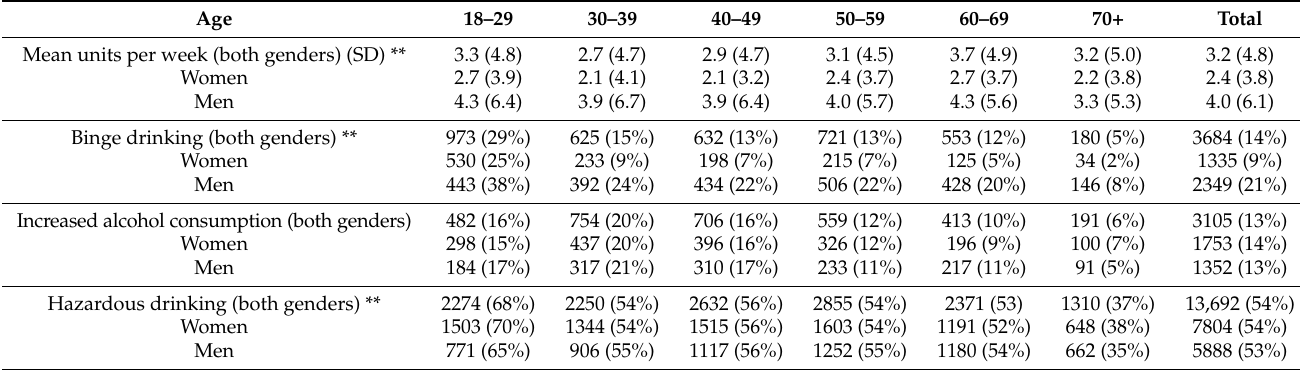
Table 2. Alcohol consumption, binge drinking, and increase in alcohol consumption in relation to age for all respondents, as well as for women and men